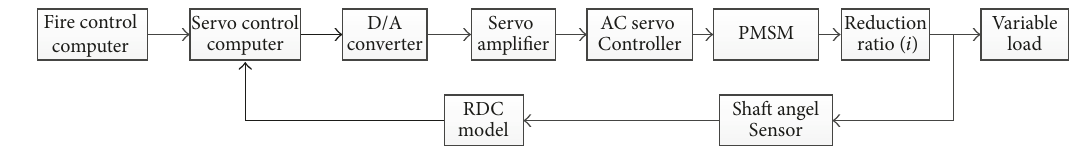
Figure 1: The principle block diagram of shipborne rocket launcher position servo